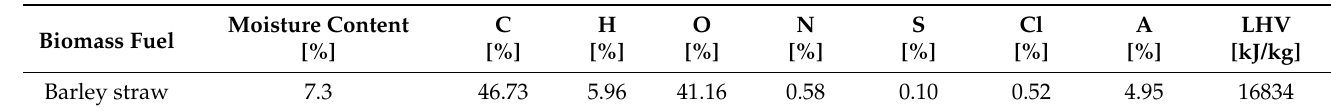
Table 2. Fuel properties: moisture content, ash content A and elementary composition of dry mass fuel, LHV fuel calorific value.